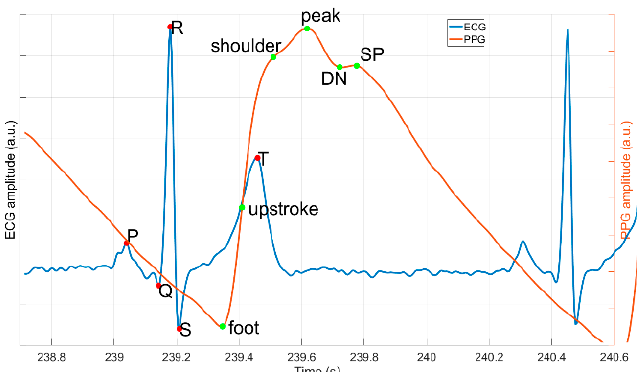
Figure 1. Example signals of one cardiac cycle with corresponding fiducials: P, Q, R, S and T waves’ peaks for electrocardiogram (ECG) (blue); and foot, upstroke, shoulder, peak, dicrotic notch (DN), and secondary peak (SP) for photoplethysmogram (PPG) (red).